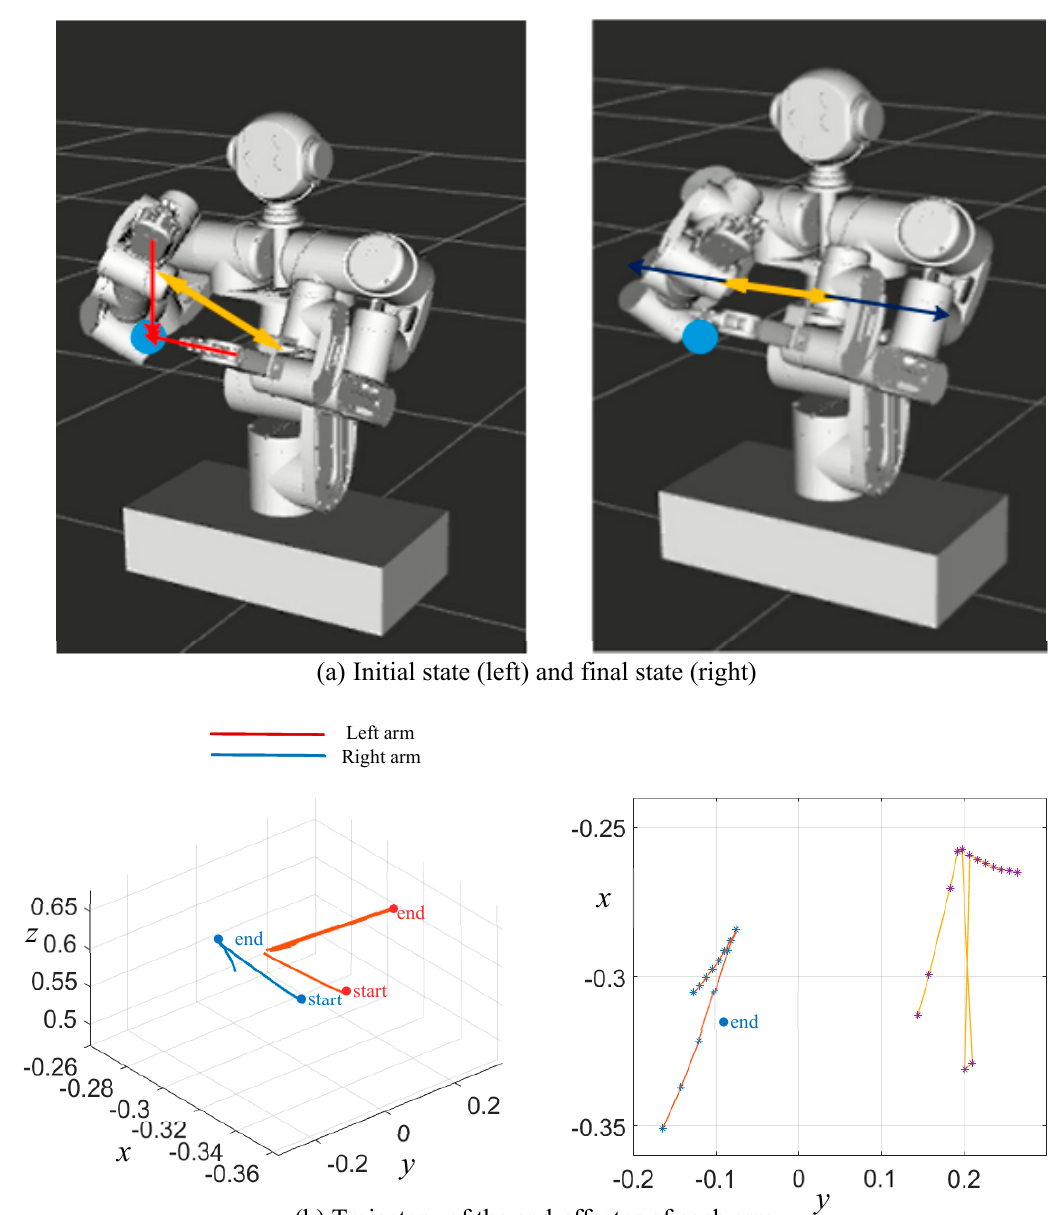
Figure 9. Process of avoiding self-collision in the dual-arm system using traditional artificial potential field method. Two arms of the dual-arm had a common target. ( a ) The initial state and final state of the robot; ( b ) Trajectory of the end-effector of each arm.